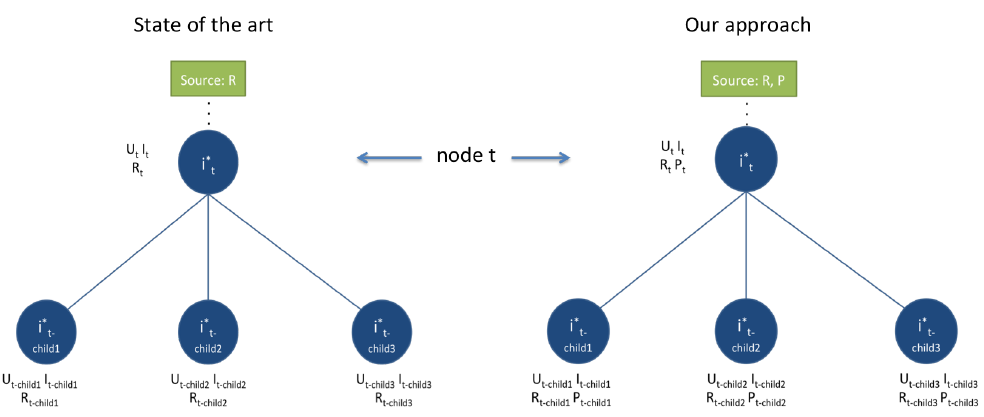
Figure 2. Illustration of our approach and comparison to the state of the art.